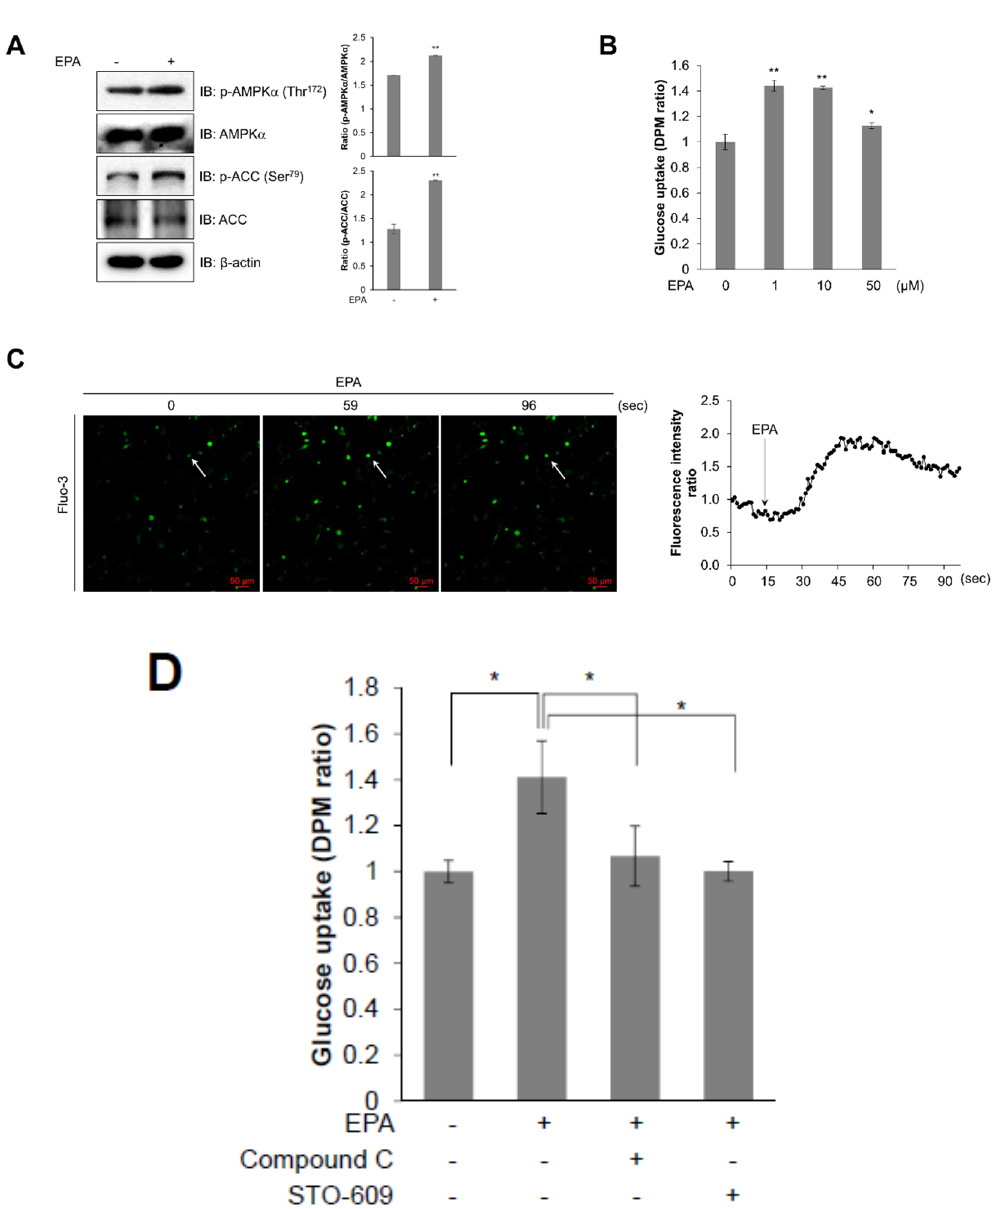
Figure 6. EPA activates AMPK and stimulates glucose uptake in primary cultured myoblasts. ( A